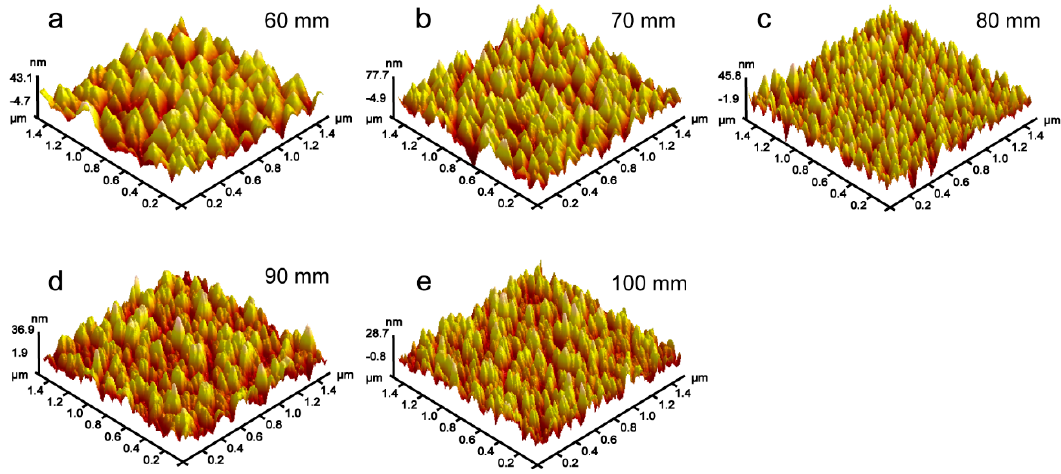
Figure 7. AFM results of V films deposited on Si (100) at T s = 400 °C, D t-s = ( a ) 60 mm, ( b ) 70 mm, ( c ) 80 mm, ( d ) 90 mm, and ( e ) 100 mm.